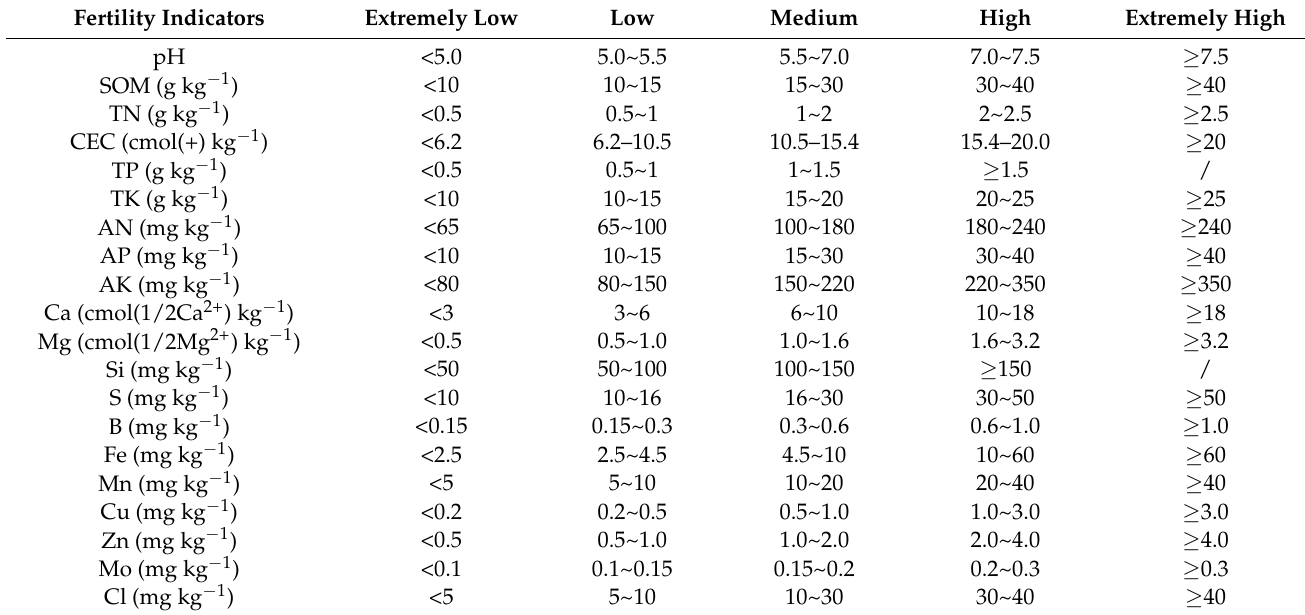
Table 1. Criteria of fertility classes for different soil